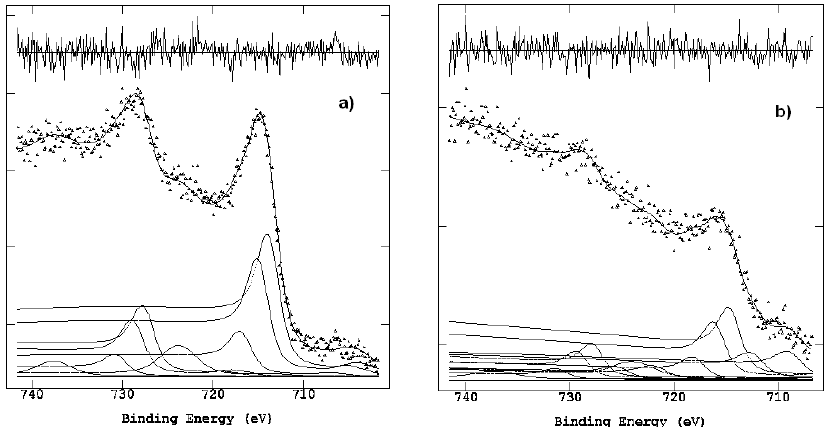
Figure 6. Spectra of the Fe region obtained for the stained Carrara samples with long outdoor exposure: ( a ) external growth layer; ( b ) interface zone. Table 2. Curve-fitting results of the XPS regions of the Carrara marble samples with long outdoor